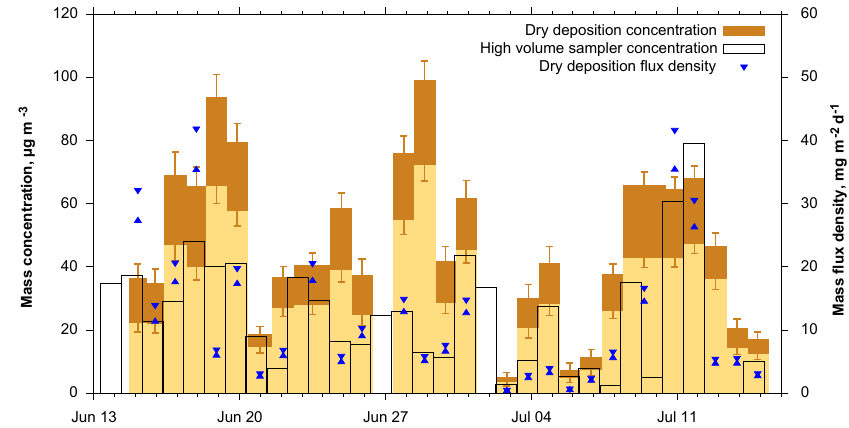
Figure 10. Dust mass concentration and flux density time series derived from DPDS compared to those obtained from a high-volume sampler (Kristensen et al., 2016). The darker brown bar shows the range from lower to upper estimate, the blue triangles the lower and upper estimate of dust deposition flux density. The date refers to the year 2013.